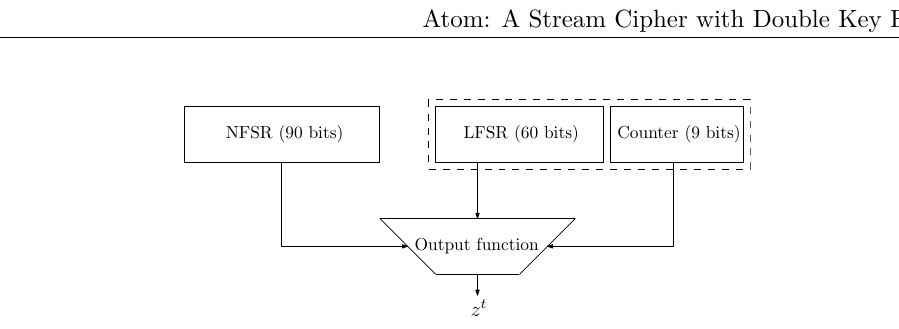
Figure 1: Overview of the construction. Note that during initialization the 69-bit LFSR is partitioned into 60 and 9 bits with each part updated by its own update logic as shown in this figure. During the keystream generation phase, both these parts function as a single 69-bit